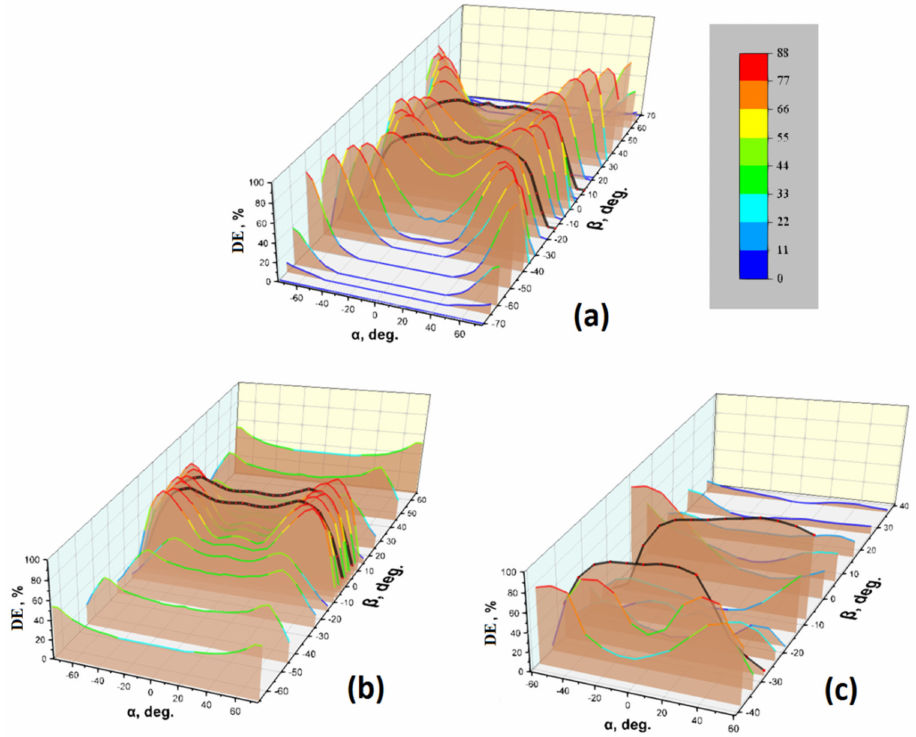
Figure 7. Diffraction characteristics of ( a ) volume, ( b ) hybrid, and ( c ) slanted